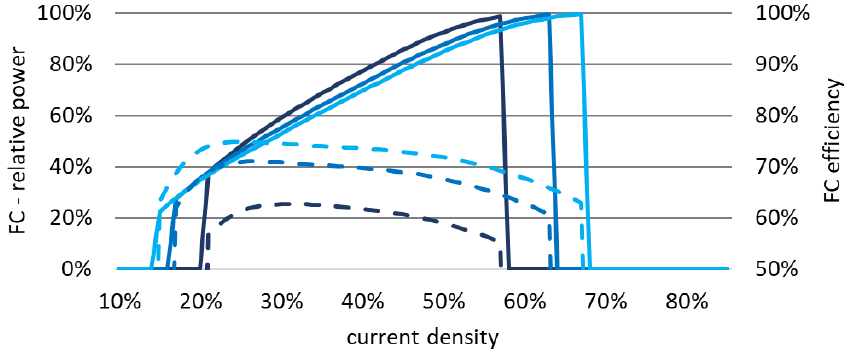
Figure 7. Expected Progress in FC efficiency (blue-dashed line) and relative power (blue-solid line) in the operating window (dark blue = 2020, medium = 2030, and bright = 2050).